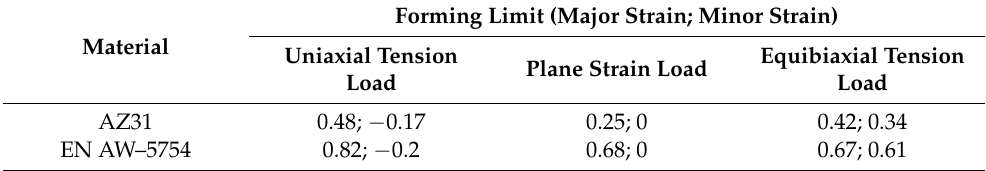
Table 1. Forming limits of the base materials at 300 ◦ C test temperature.